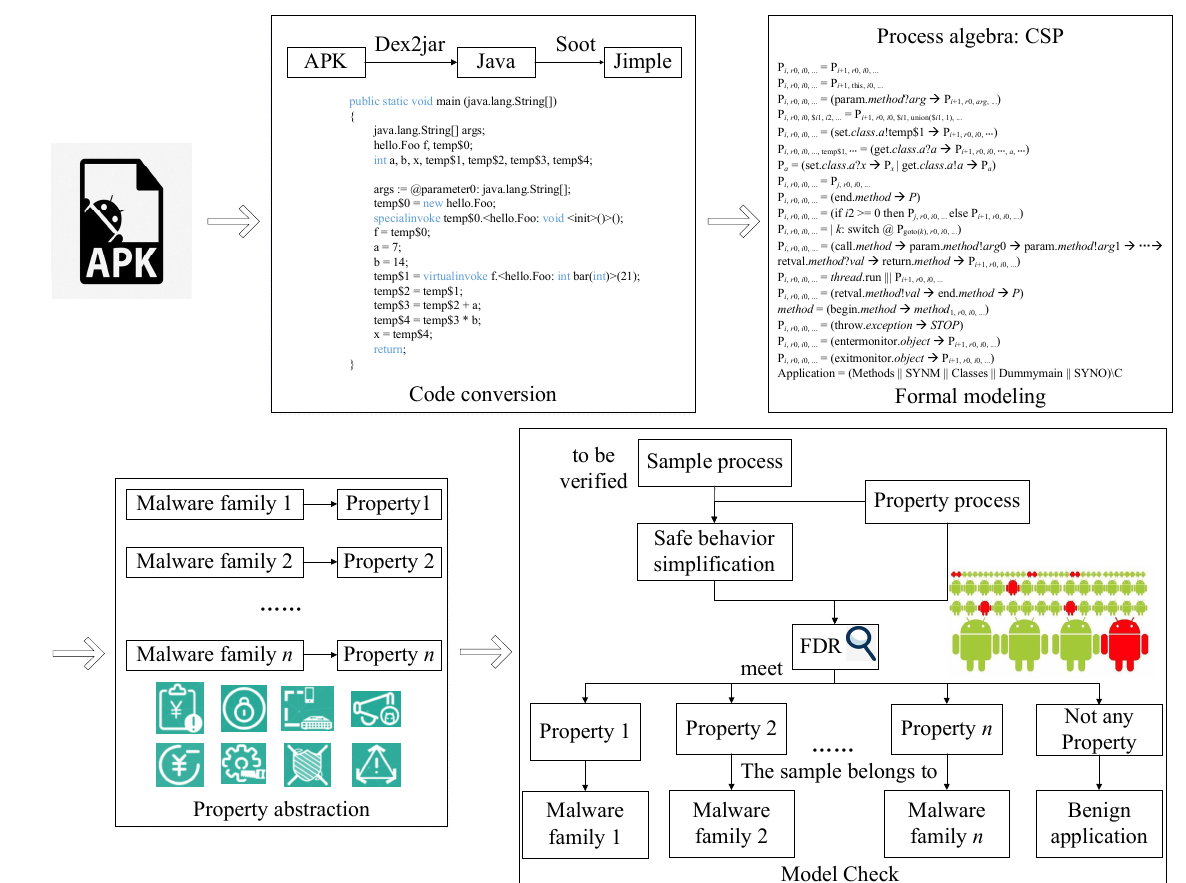
Figure 3. System design of